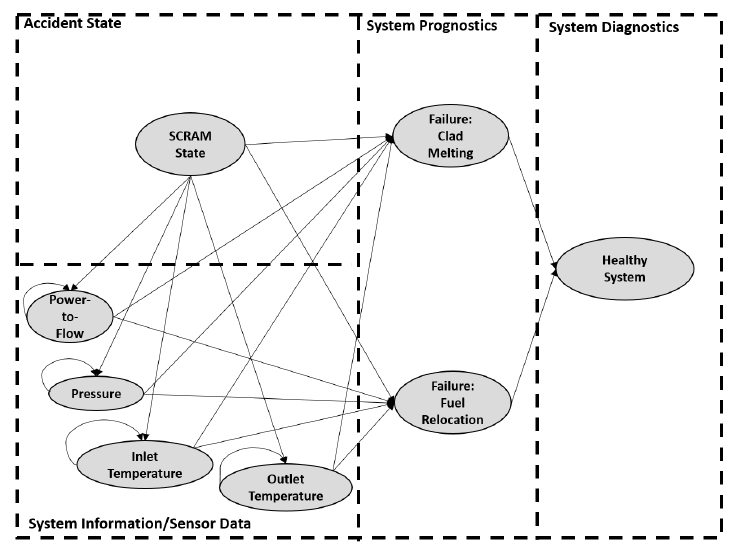
Figure 5. DBN node structure and relationship graph for the SFR transient overpower (TOP) case study. The dashed boxes represent the different node regions for a diagnostics and prognostics model for CES. The arrows are reflective on the current time step, with the exception of the dynamic relationship in the nodes in the “System Information/Sensor Data”